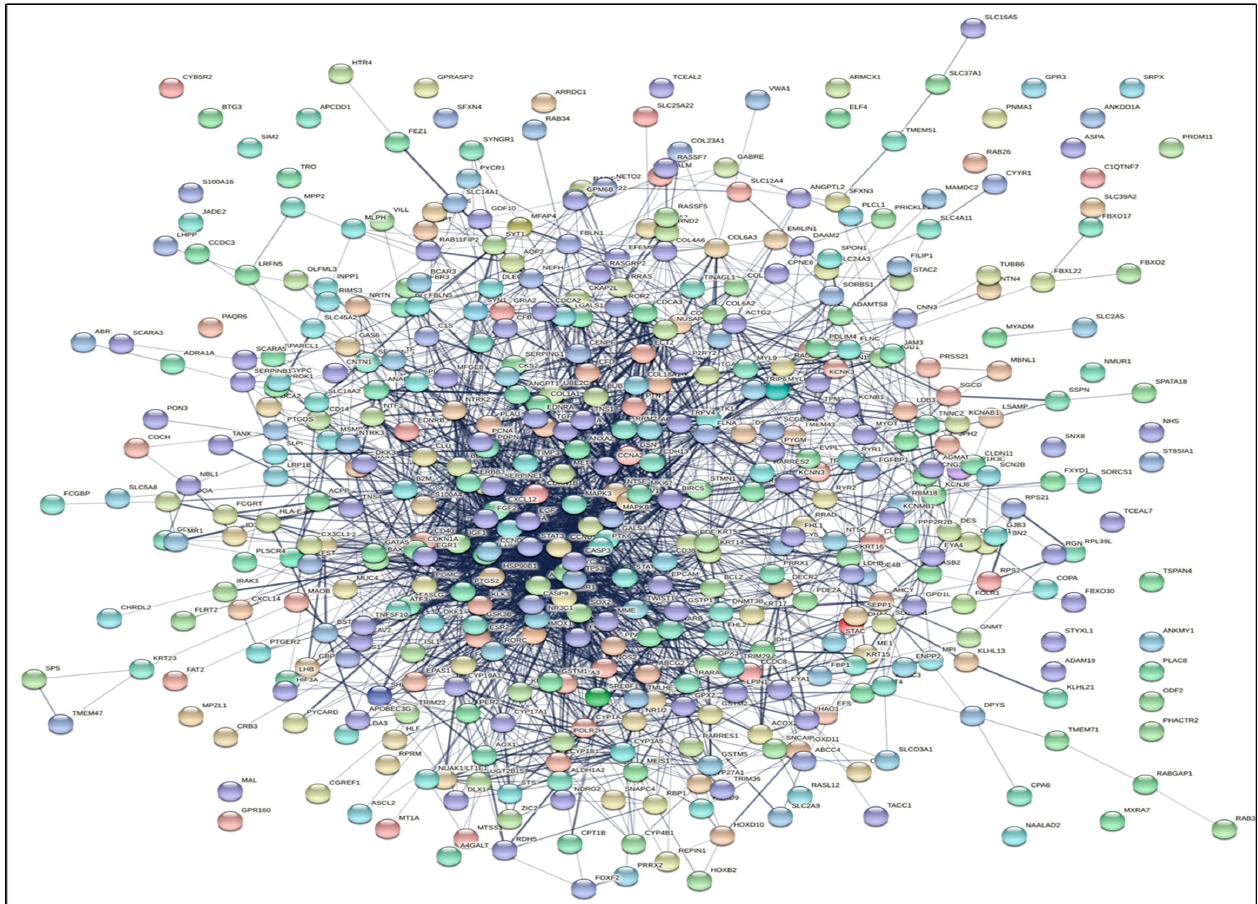
Figure 3. STRING database analysis of the PPI networks for the functional enrichment analysis yielded DEGs for 369 overlapping genes (nodes) and 2637 edges with degree > 11.2 and PP enrichment p -value < 1.0 × 10 − 16 .